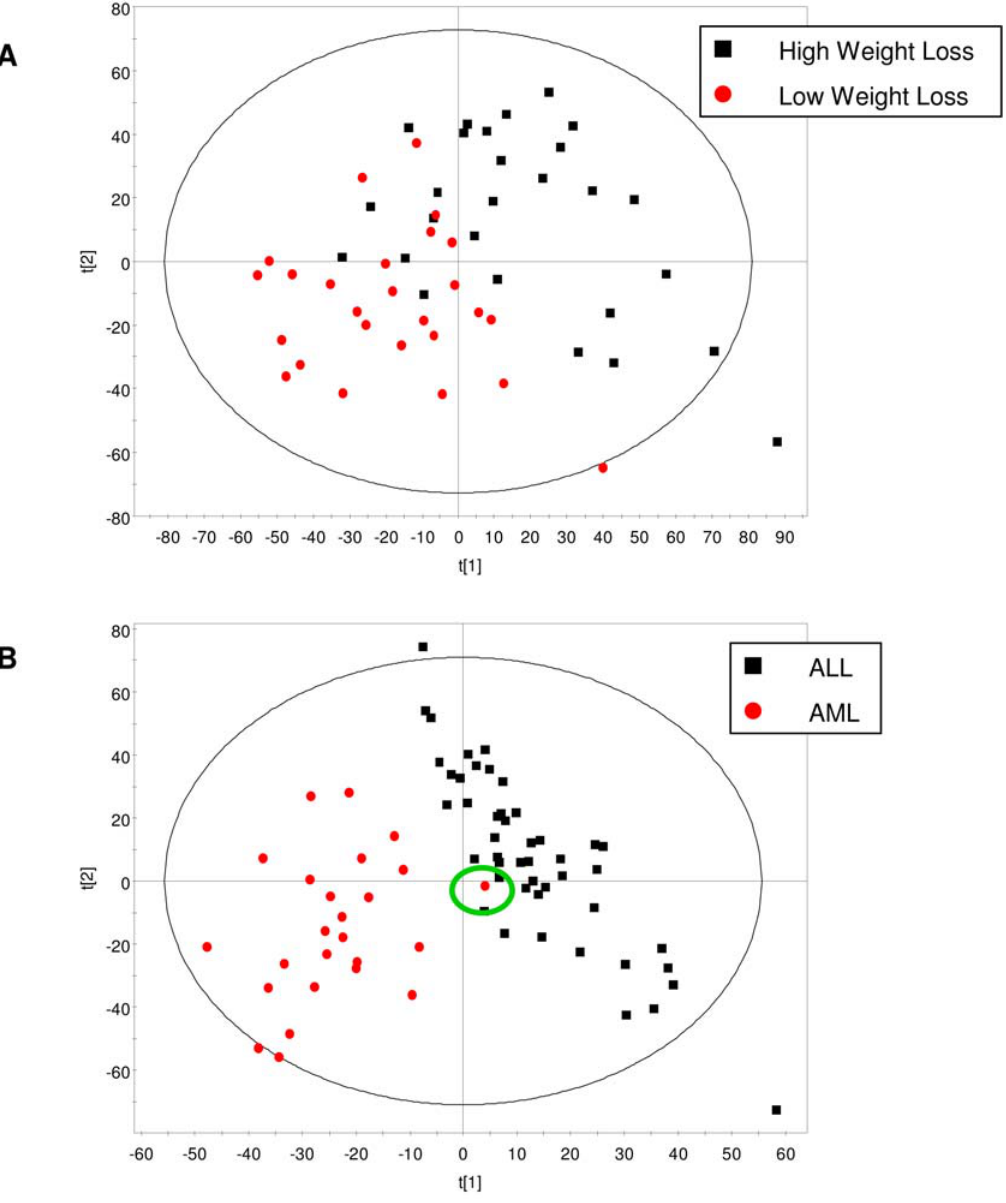
Figure 3. A. Differentiating populations by PLS-DA. Global gene expression analysis in sub-cutaneous tissue reveals a separation trend between dietary responders (black squares) and non-responders (red circles); however, there is a significant overlap between the two populations (R 2 =0.547 and Q 2 = 2 0.096). B. ALL patients (black squares) can be clearly separated from AML patients (red circles), apart from a single patient (identified by the green circle) (R 2 =0.795 and Q 2 =0.622). R 2 explains the cumulative variation of the first two components and Q 2 indicates the variation explained by the model according to cross validation. Only a Q 2 . 0.5 indicates a good model. doi:10.1371/journal.pone.0001344.g003 (KNN), and diagonal linear discriminant analysis (DLDA) using a